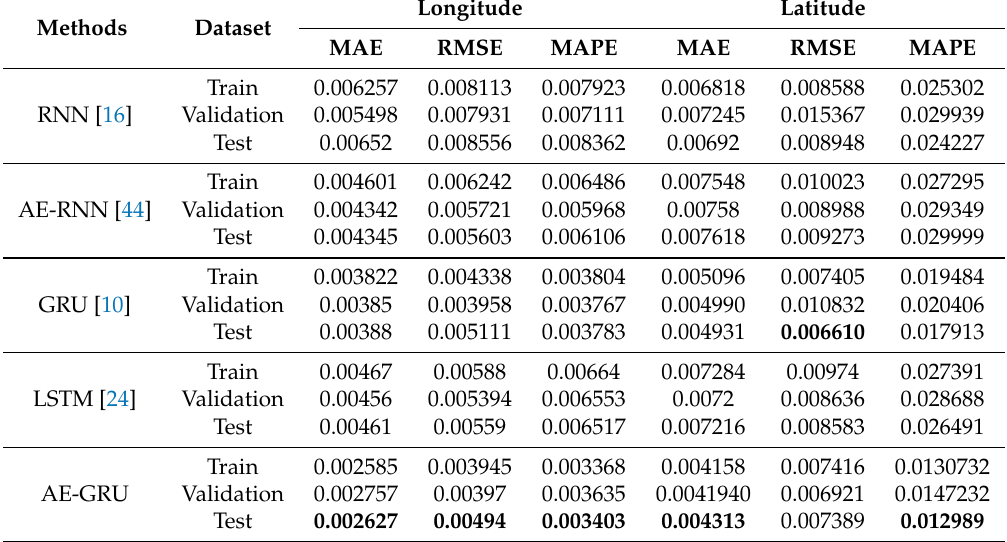
Table 6. The prediction results of RNN, AE-RNN, GRU, LSTM, and AE-GRU using MAE, RMSE, and MAPE.